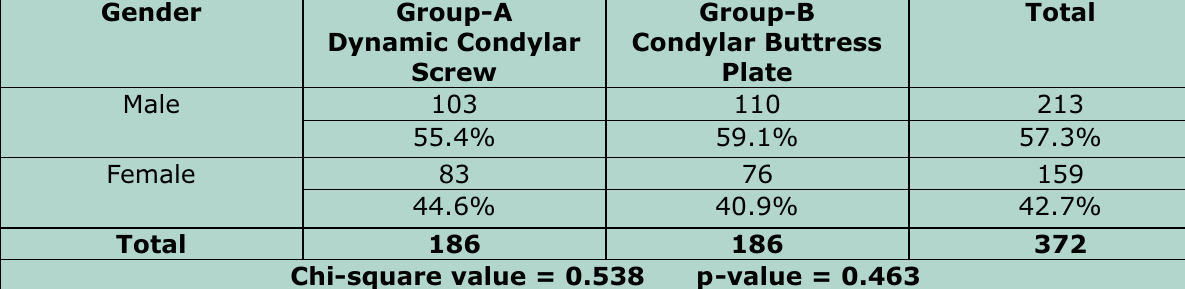
Table of association among the gender and both